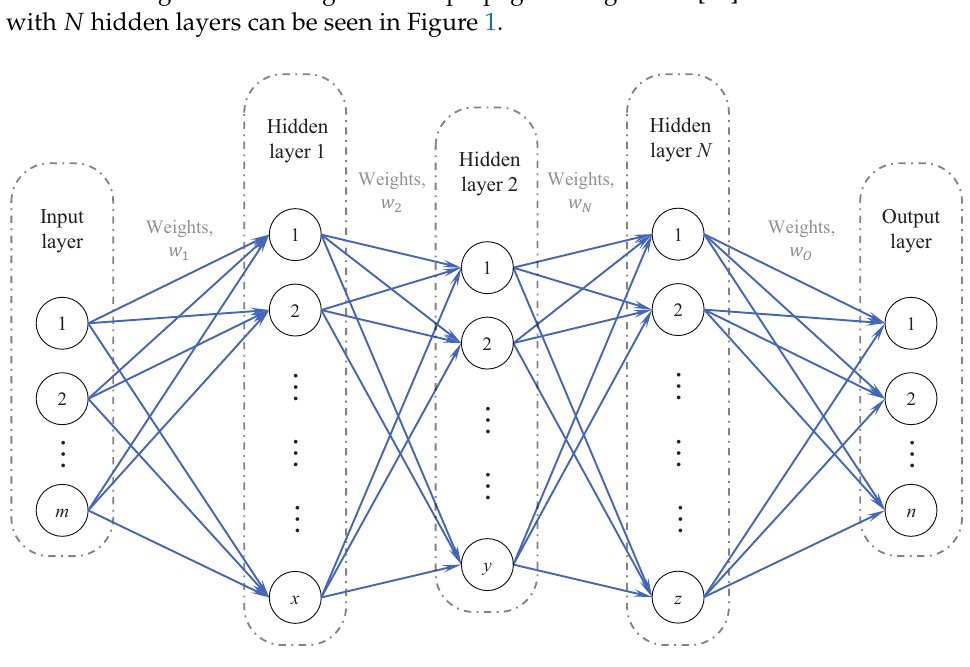
Figure 1. Schematic of an artificial neural